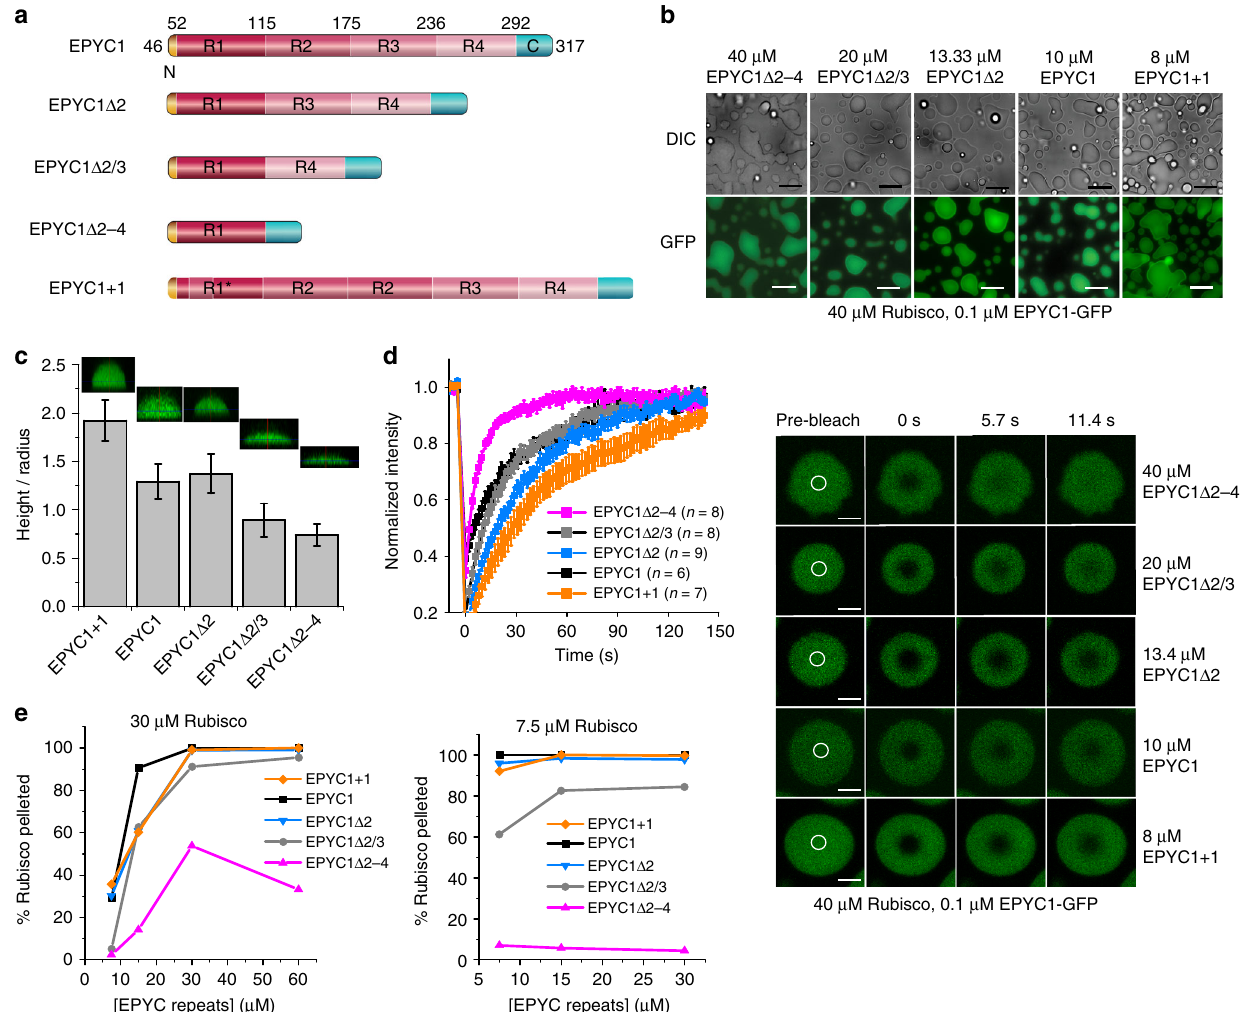
Fig. 5 The role of the EPYC1 tandem repeats. a Schematic representation of EPYC1 constructs including deletions or additions of the repeat regions. Note, R1* indicates a chimeric repeat containing a short R2 sequence insertion. b All tested constructs are able to demix Rubisco. Three-minute incubation time prior to imaging within the subsequent 2 – 6 min. Scale bar 15 µ m. c EPYC1 proteins with fewer repeats form fl atter droplets than variants with higher valency; conditions as in b . Error bars indicate the s.d. ( n = 42 – 50; data points shown in Supplementary Fig. 8d). d Droplets containing the lowest-valency construct recover more rapidly from photobleaching. Sample size n and s.e.m. indicated. Scale bar 2 µ m. e Lower-valency (one to two repeats) EPYC1 variants require higher Rubisco concentrations to phase-separate as measured using the droplet sedimentation assay. EPYC1 variants containing three, four, or fi ve repeats behave